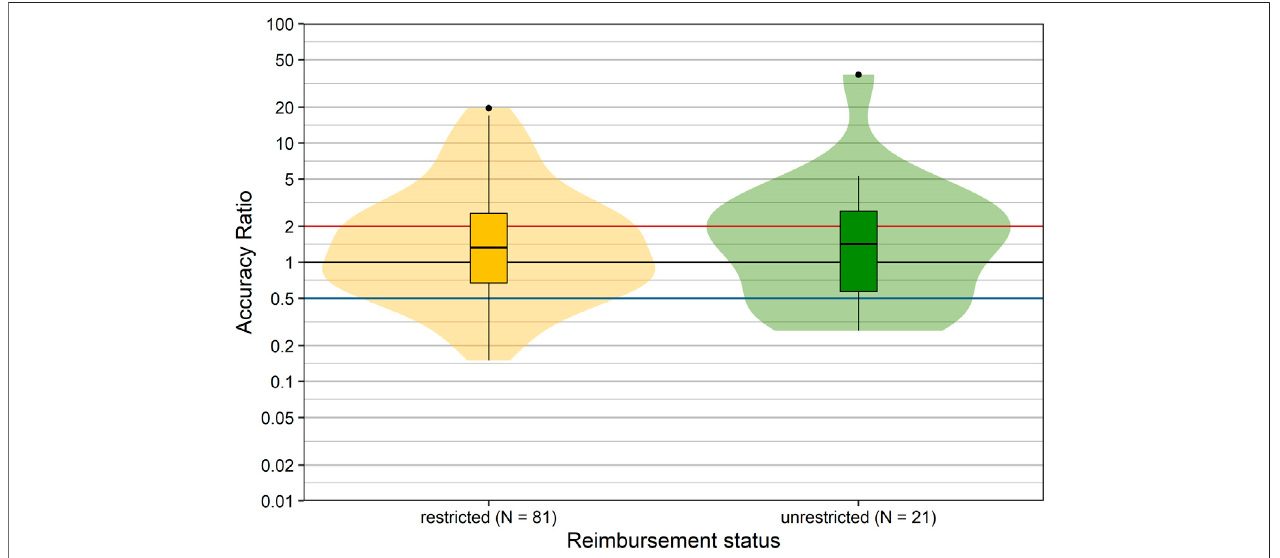
FIGURE 5 | Comparison of accuracy ratios by reimbursement status. Box plots and violin plots show accuracy ratios of forecasted sales in the 3 years after a positive reimbursement decision, grouped according to reimbursement decision. Due to their asymmetric nature, accuracy ratios are plotted on a logarithmic (base 10) scale to avoid visually overemphasizing overestimates compared to